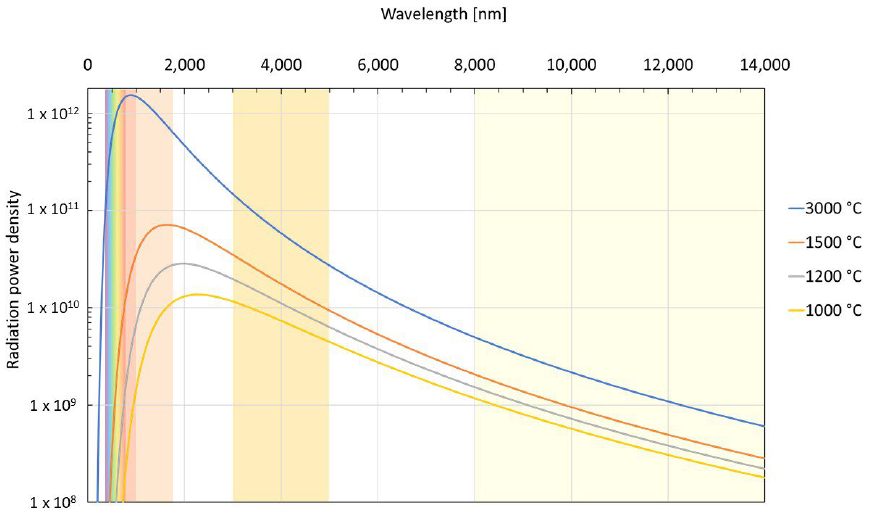
Figure 1. Blackbody radiation is a function of temperature. High-temperature objects emit most of the radiation in the near- to mid-infrared. The infrared spectral range is usually divided in visible spectrum (VIS, 380–750 nm), near-infrared (NIR, 750 nm–1 µ m), short-wavelength infrared (SWIR, 1–1.7 µ m), mid-wavelength infrared (MWIR, 3–5 µ m), and long-wavelength infrared (LWIR, 8–14 µ